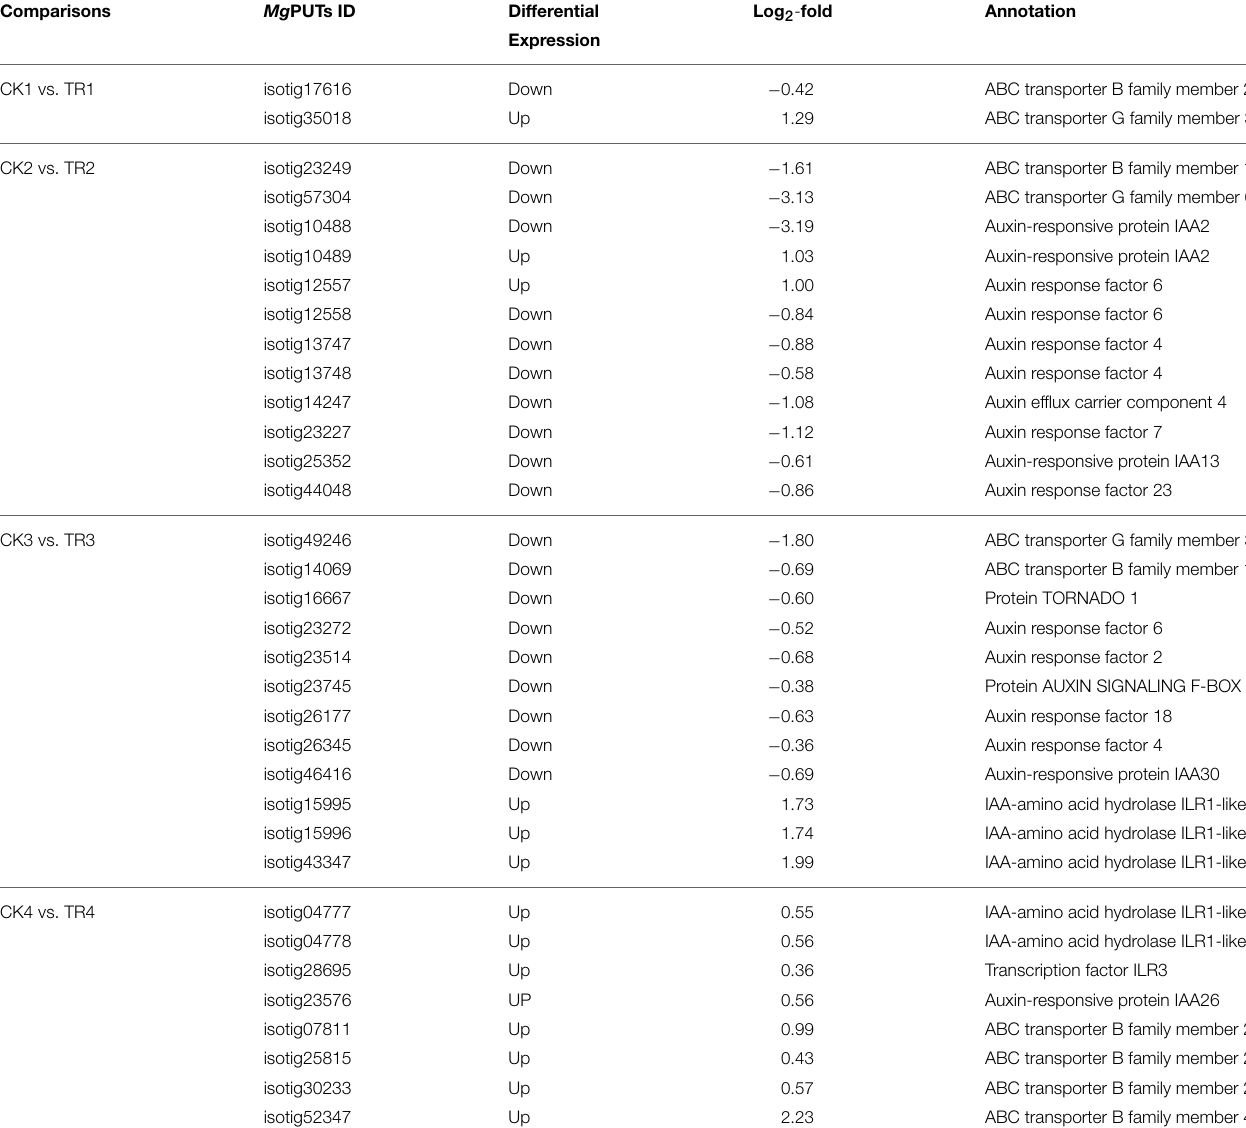
TABLE 5 | DE genes related to hormone signals in the vegetative to reproductive phase transition.